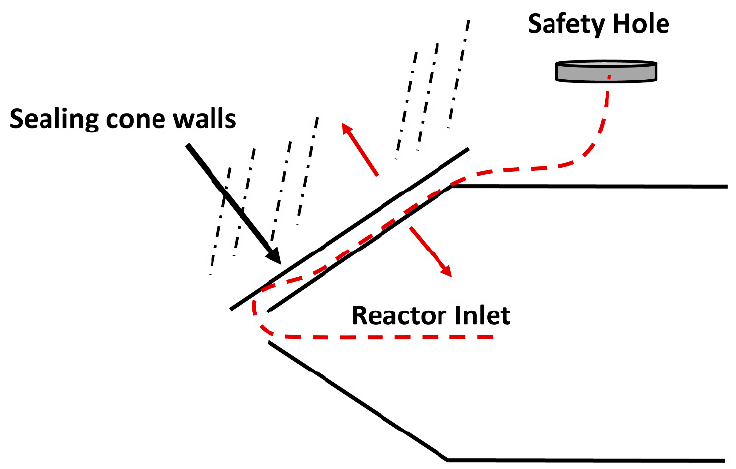
Figure 4. Sealing method and safety system for the SCWG reactor.